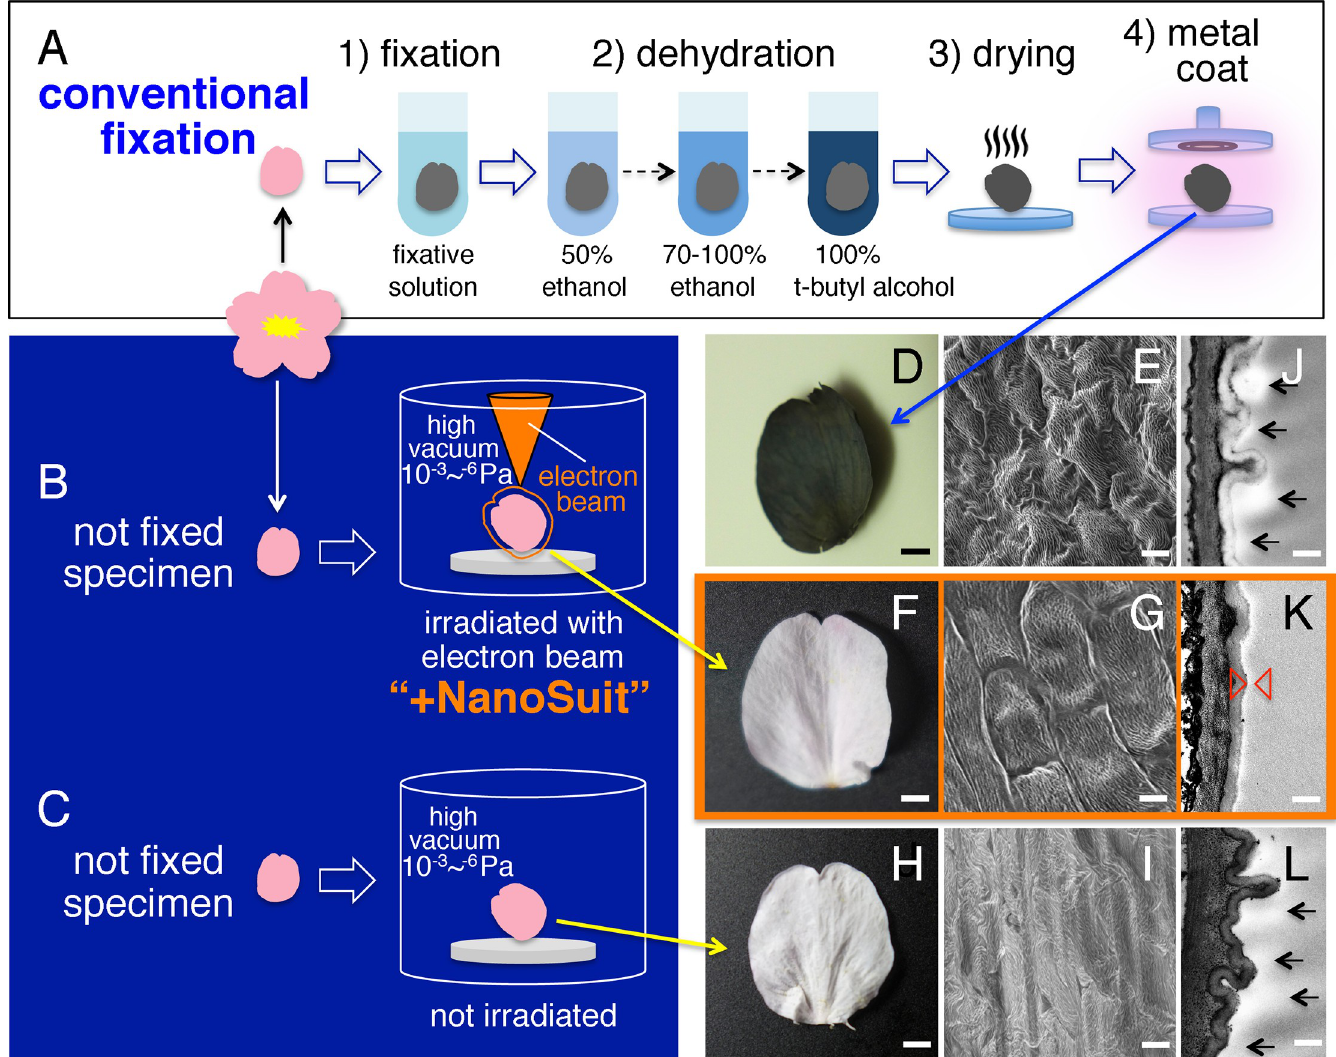
Fig 1. Preparation of specimens for SEM and subsequent optical, SEM, and TEM images. Schematic of specimens (A) prepared with conventional fixation methods, (B) treated by the NanoSuit method, and (C) placed in the SEM observation chamber, but without concurrent electron beam radiation. Images of cherry blossom petals obtained by (D, F, H) light microscopy and (E, G, I) SEM. SEM images were taken by 1,000x (E, G, I) with acceleration voltages of 5.0 kV (E) or 1.0 kV (G, I) at working distances of 7.1 mm (E), 6.6 mm (G), or 7.2 mm (I) under vacuum conditions of 1.6 − 3 Pa (E), 1.9 − 4 Pa (G), or 1.4 − 3 Pa (I). (J, K, L) Transmission electron microscopy (TEM) images of petal cross sections. The arrows in J and L indicate the position of the surface material covering the petals (white layers). The white layer between the arrowheads in K indicates the newly formed NanoSuit. Scale bars are (D, F, H) 2 mm, (E, G, I) 10 μ m, and (J, K, L) 300 nm.